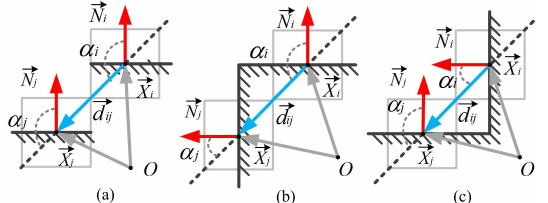
Figure 3. (a) Adjacent voxels in a neighborhood. (b) Fully connected local